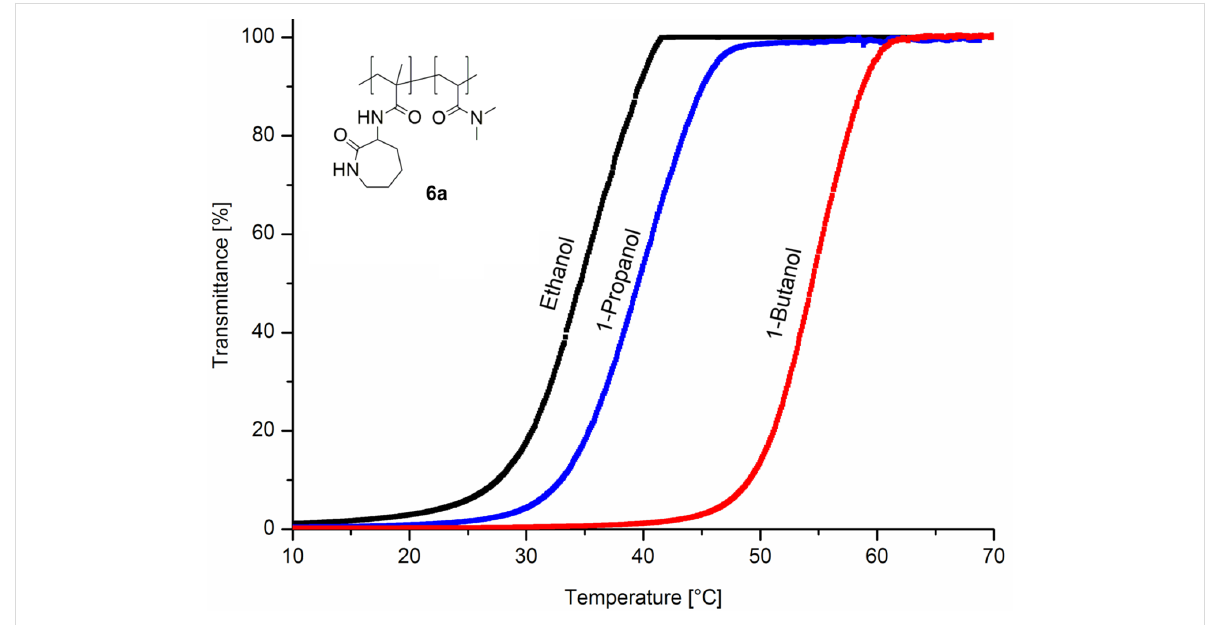
Figure 3: Turbidity curves upon cooling of 10 mg ml − 1 solution of copolymer 6a in various n -alcohols at a cooling rate of 1 °C min − 1 .